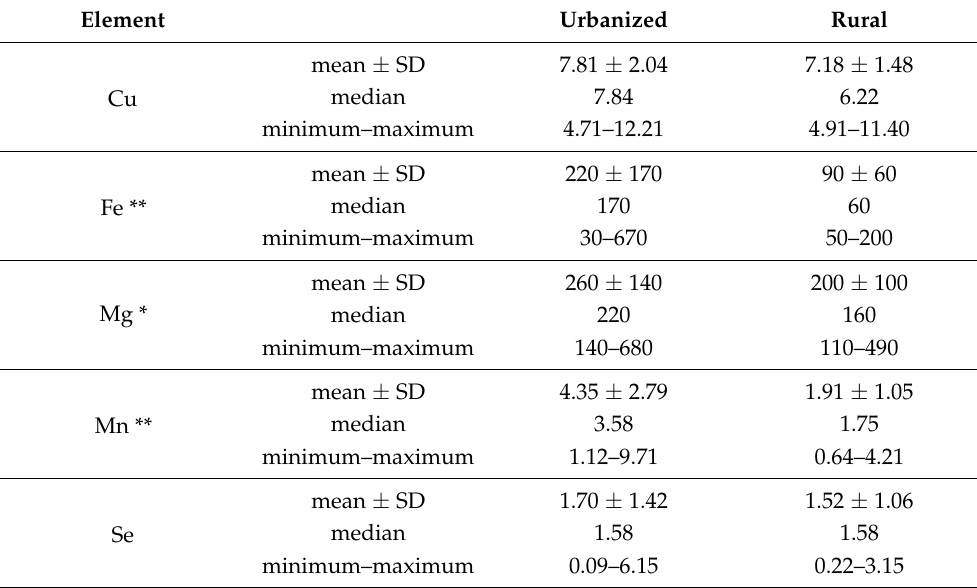
Table 5. Differences detected between urbanized and rural areas (mg · kg − 1